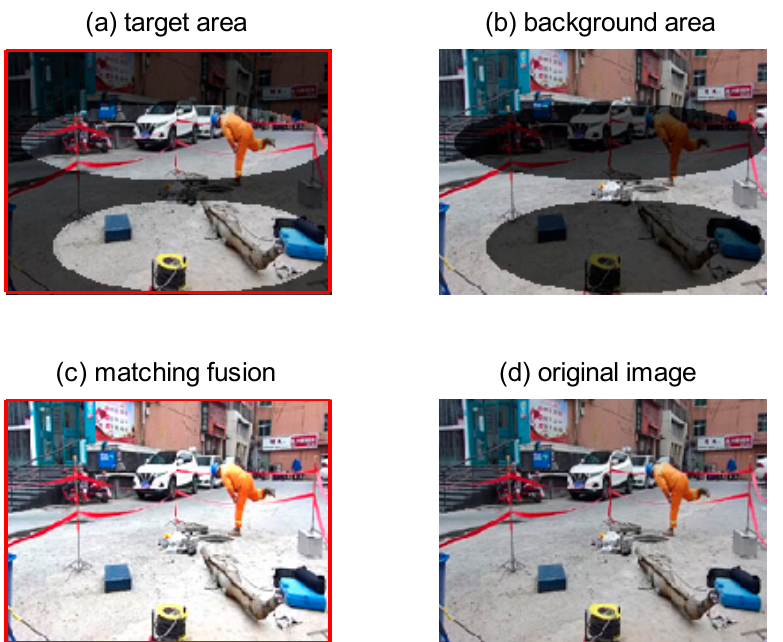
Figure 9. Matching results of the proposed correlation matrix matching method for two images.